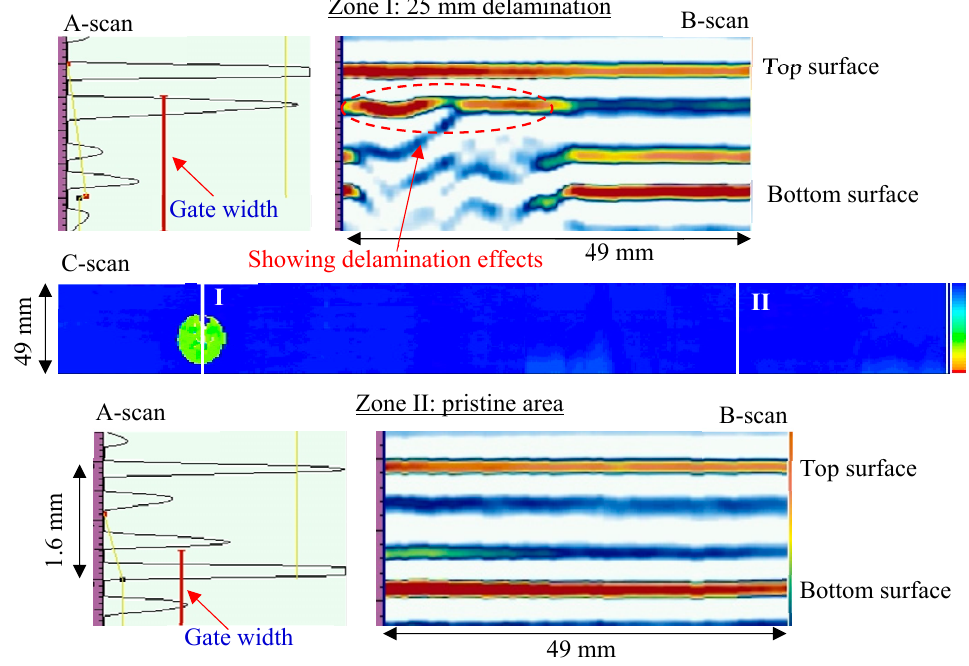
Figure 6. NDT results of the first inspection area on the cross-ply [0/90] 2s CFRP composite plate: pristine area and 25 mm delamination.